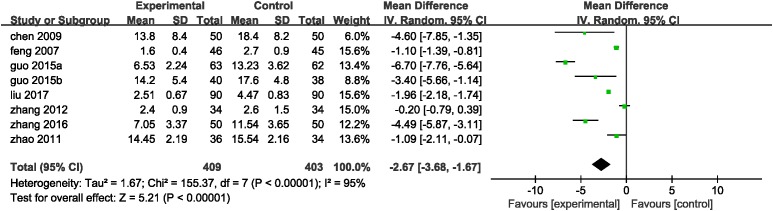
Forest plot of hsCRP in patients treated with DHI + PCI and PCI alone. I2 and P are the criterion for the heterogeneity test. ♦ Pooled odds ratio, ——mean difference and 95%CI.